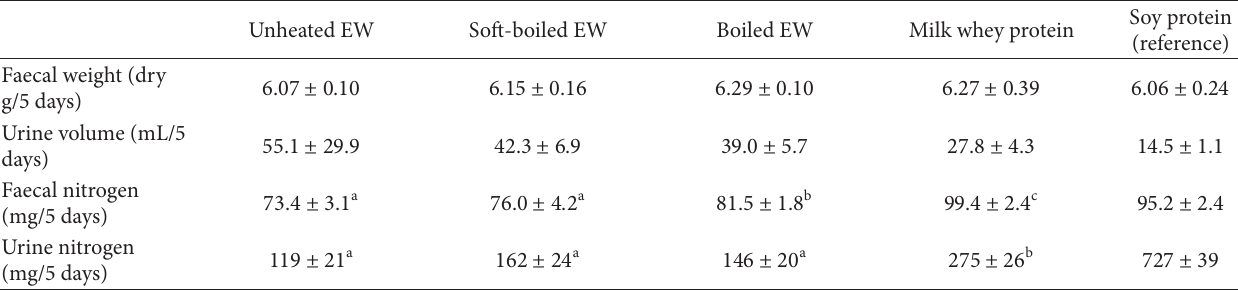
Table 2: Faecal and urine nitrogen content in rats fed a diet containing EW (unheated, soft-boiled, or boiled), milk whey protein, or soy protein. Unheated EW